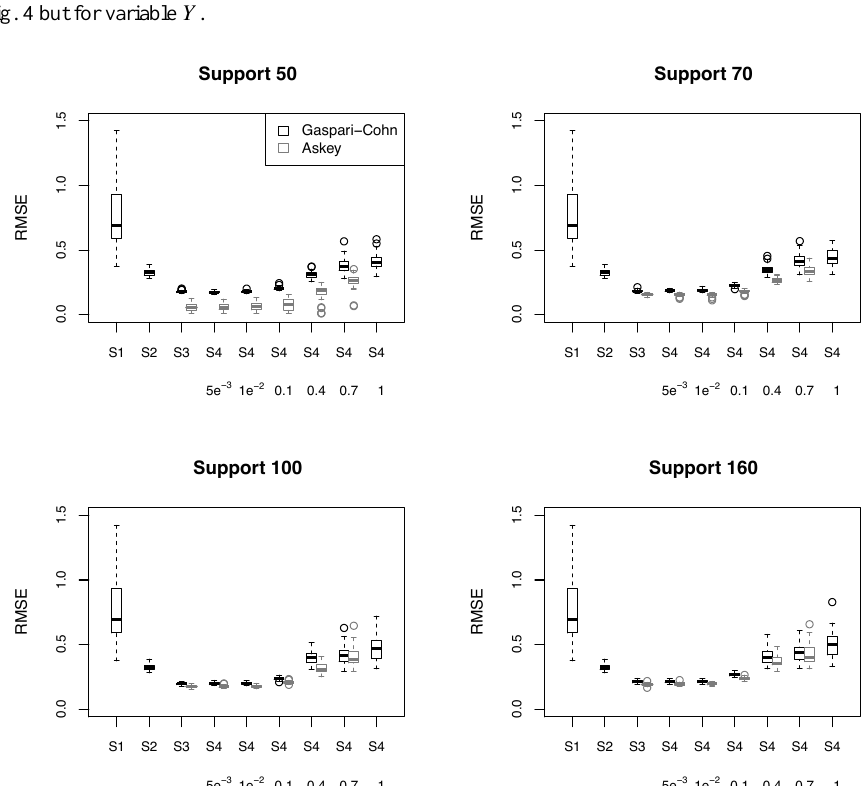
Figure 5. Same as Fig. 4 but for variable Y .